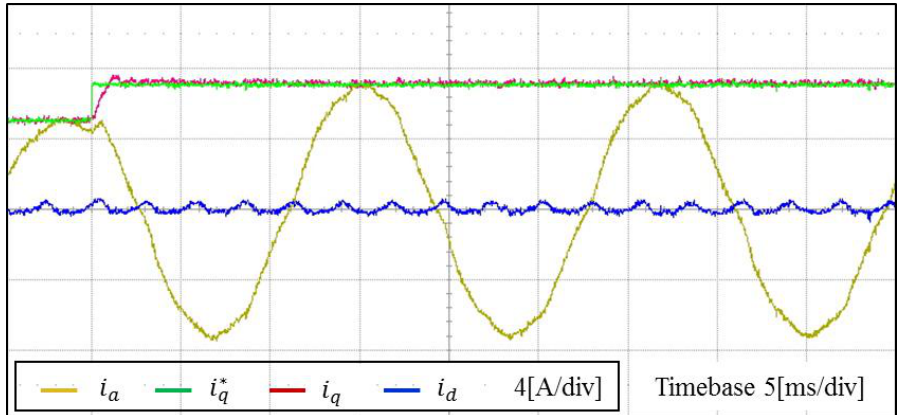
Figure 23. Step response of the inverter currents using the proposed control scheme under the distorted grid voltages.